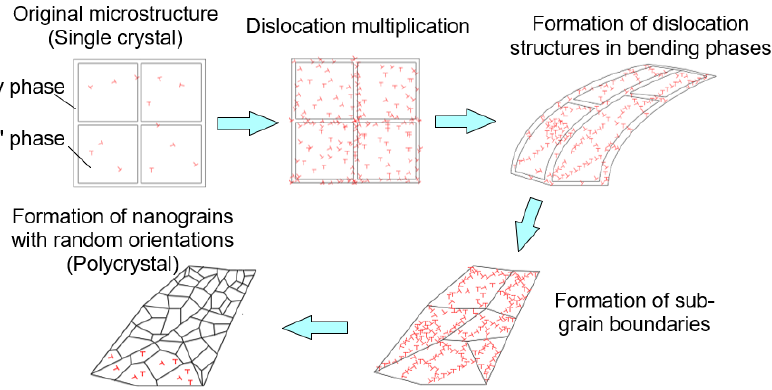
Figure 8. Schematic illustration of the gradient structure evolution.